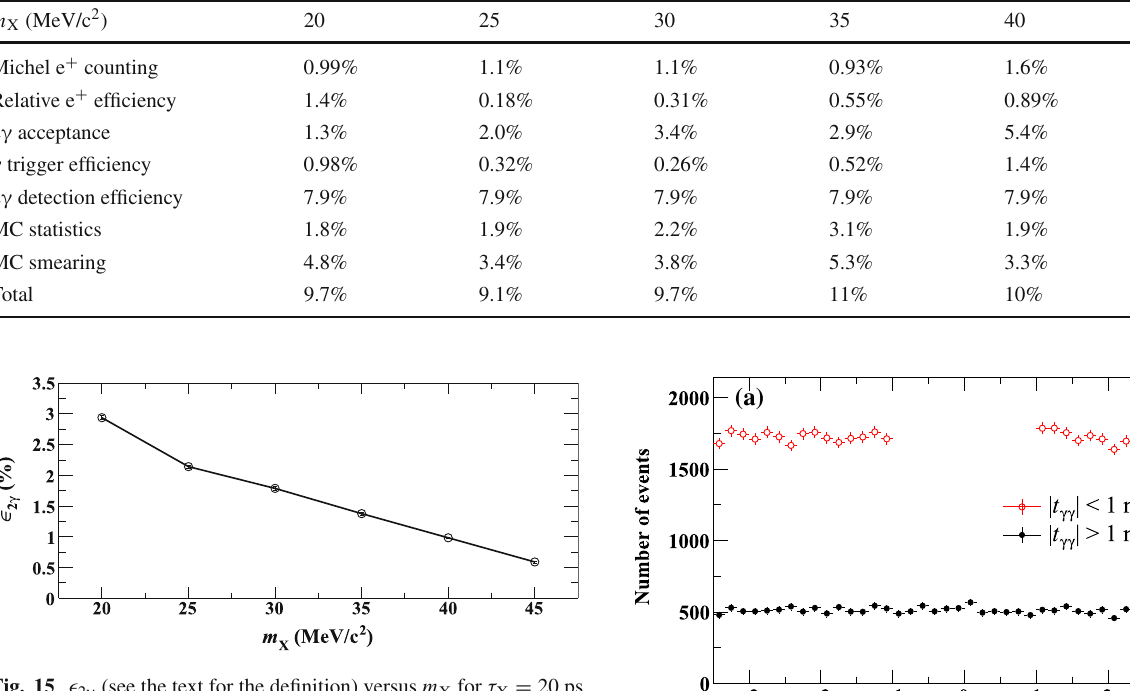
The estimated value of SES is s 0 = ( 2 . 9 ± 0 . 3 ) × 10 − 12